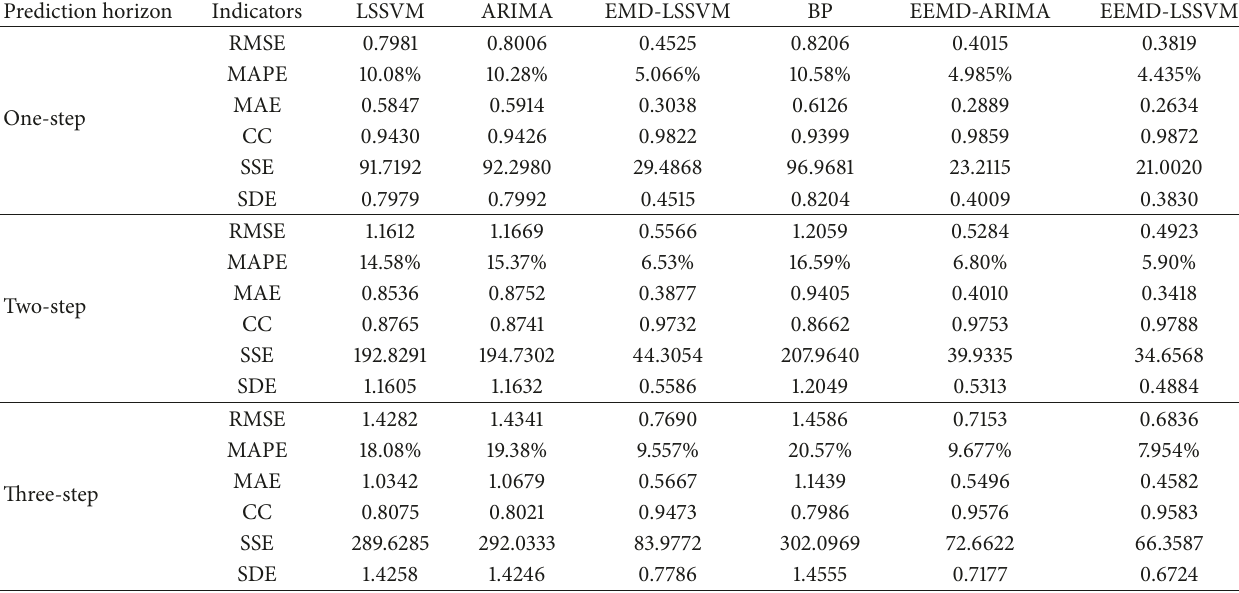
Table 3: Performance comparison of different models for forecasting wind speed (Case